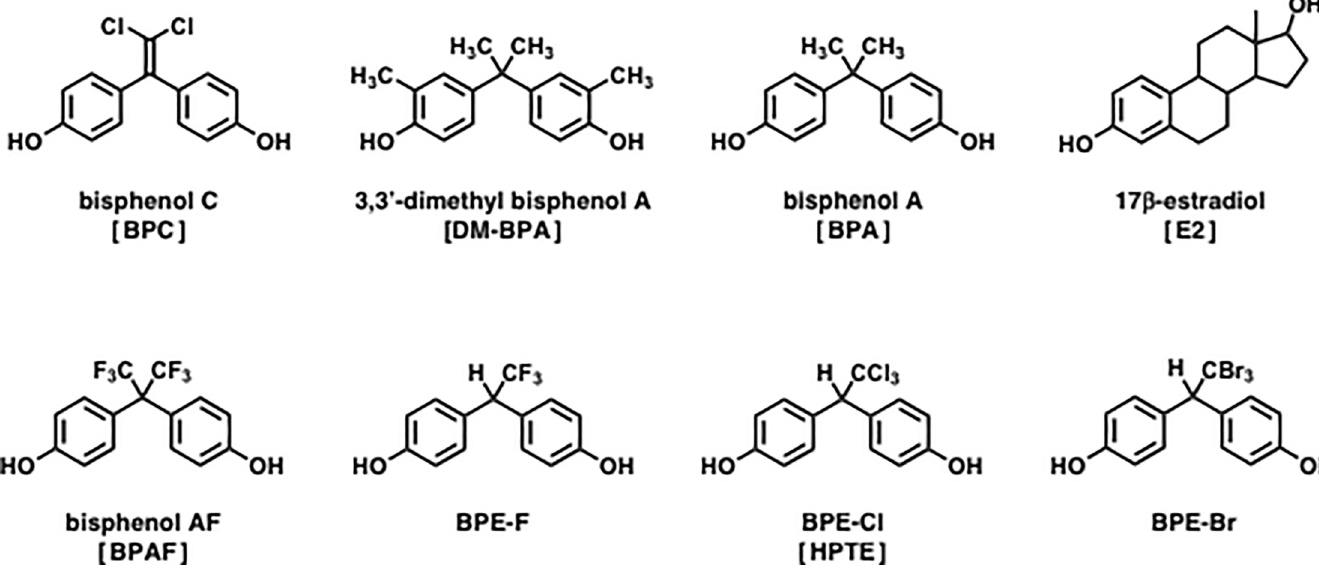
Fig 1. Chemical structures of the bisphenol compounds examined for estrogen receptor ER α and ER β . 3,3’-Dimethyl bisphenol A (DM-BPA) is often and confusingly labeled “bisphenol C (BPC)”, and was not tested in this study. 17 β -Estradiol (E2) was tested as a standard natural agonist compound.